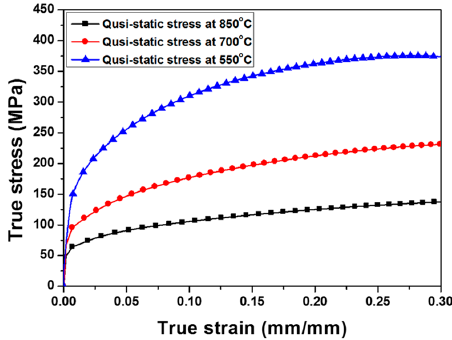
Figure 4. The strain-stress curve at quasi-static state for boron steel with various temperatures.